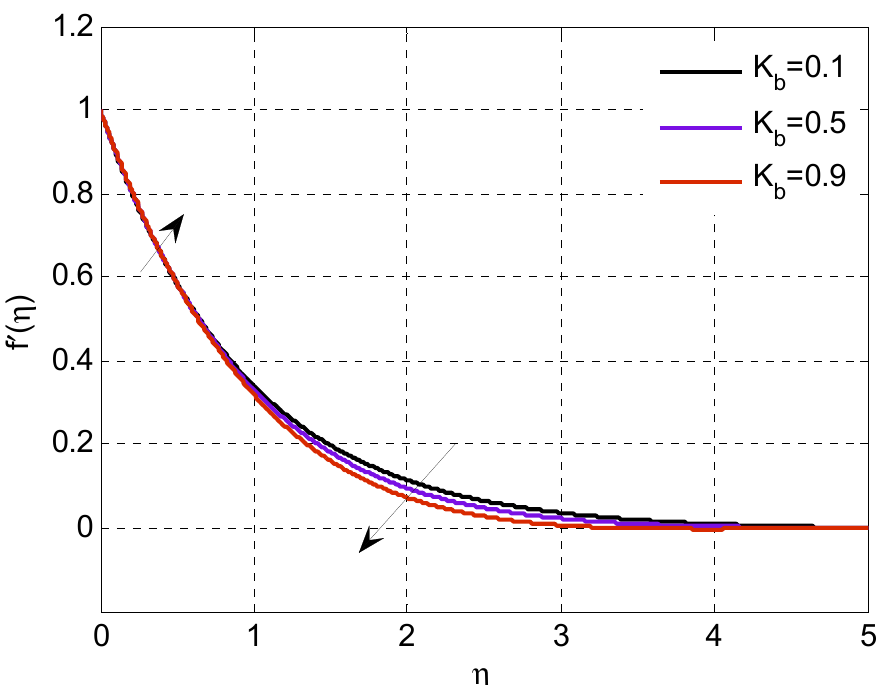
Figure 7. Effect of coupling parameter on velocity profile using G = 1, λ = 0.1, and F r = 0.1.